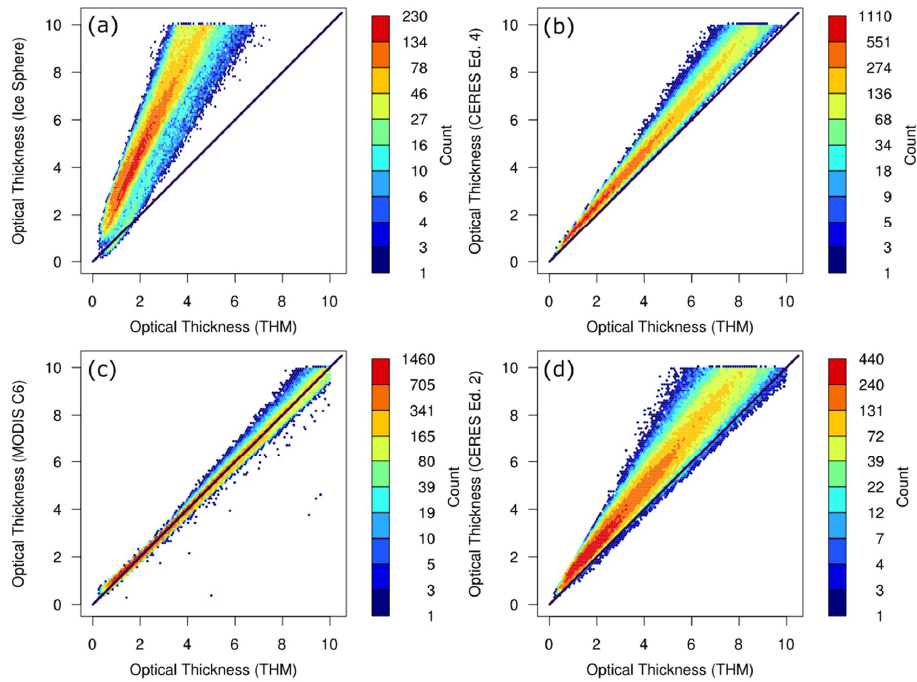
Figure 18. Comparison of retrieved optical thickness values from the shortwave technique (shortwave bi-spectral method): ( a ) ice sphere and two-habit model (THM; potential CERES Edition 5 model); ( b ) CERES Edition 4 model and two-habit model; ( c ) MODIS Collection 6 model and two-habit model; and ( d ) CERES Edition 2 model and two-habit model. Atmosphere 2018 , 9 , x FOR PEER REVIEW